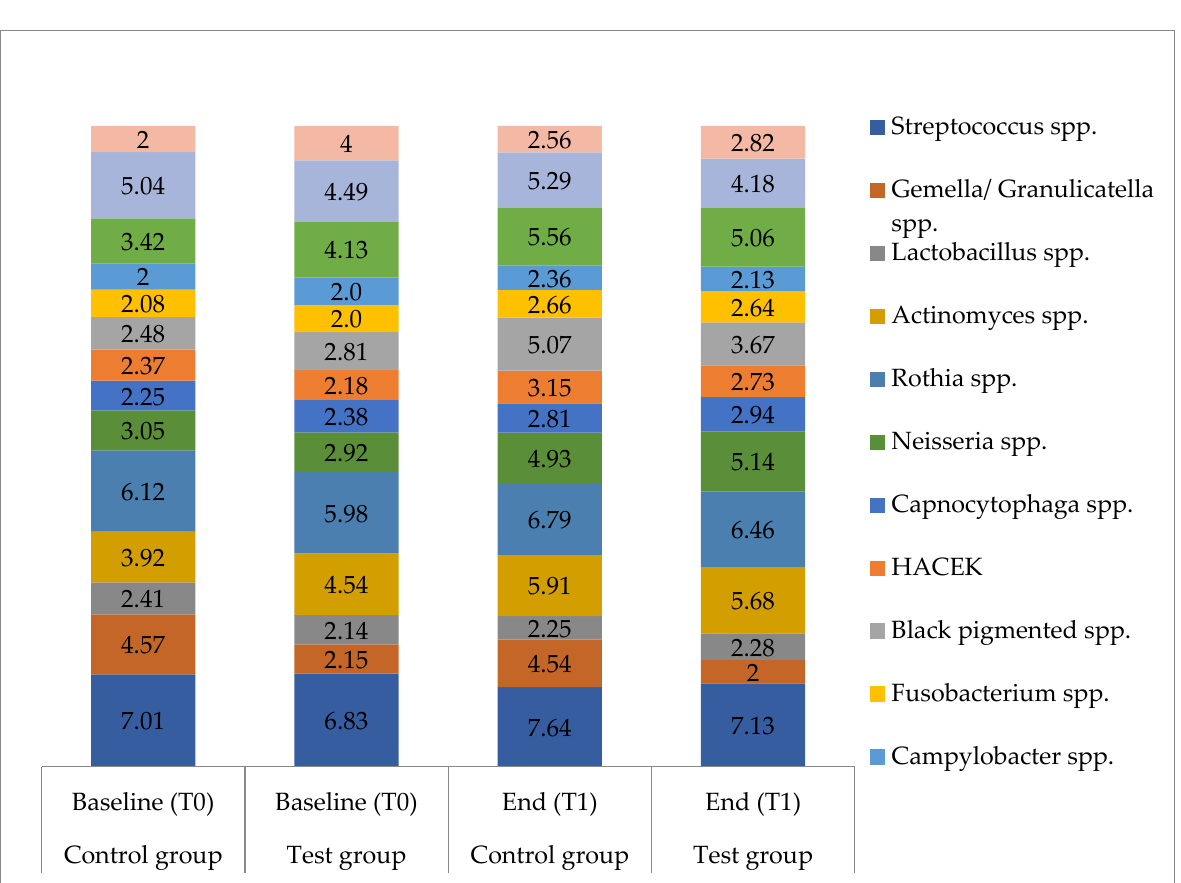
Figure 3. Gram-negative and Gram-positive species detected in saliva. Bacterial counts of Gram-negative and Gram-pos- itive bacterial species for the test group and the control group at baseline (T0) and after 36 months (T1); values are given as means in log10 CFU/mL; n = 16 for each group.